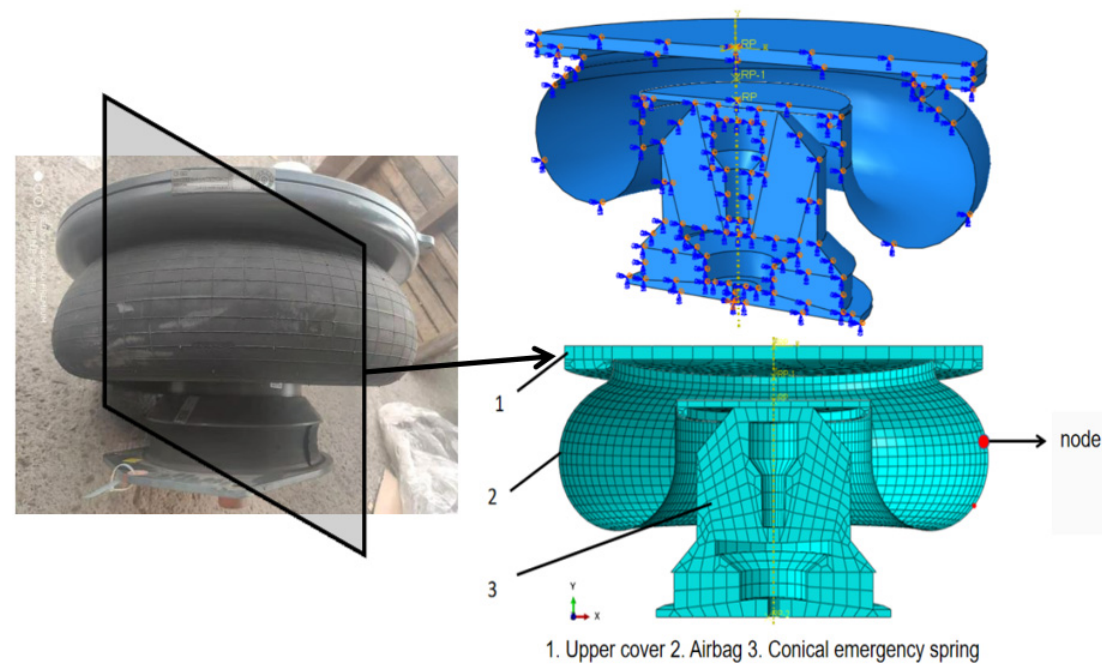
Figure 4. Finite element model of air spring.